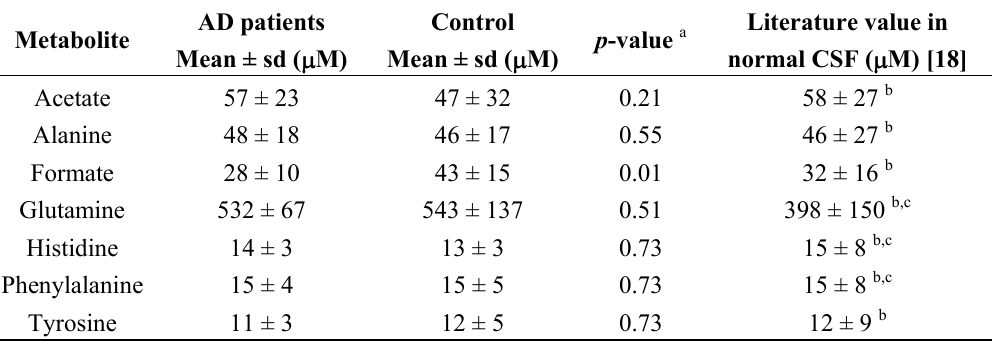
Table 2. Concentrations of selected CSF metabolites in Alzheimer’s disease (AD) patients (n = 15) and control subjects (n =